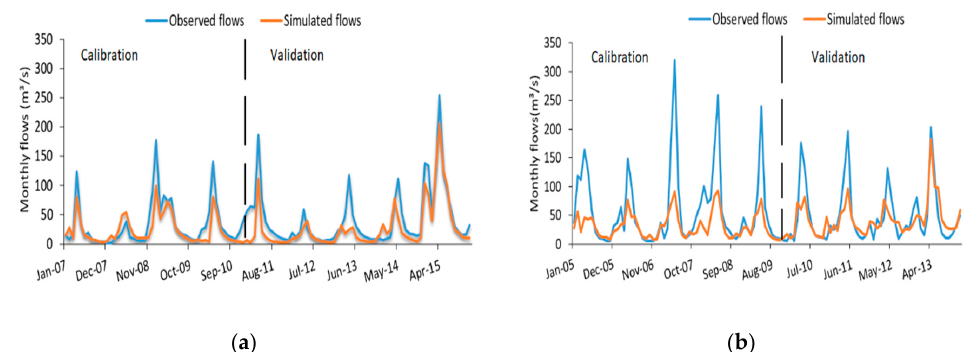
Figure 2. Model performance results for ( a ) the 1G1 gauging station, Wami River, and ( b ) the 1H8 gauging station, Ruvu River.